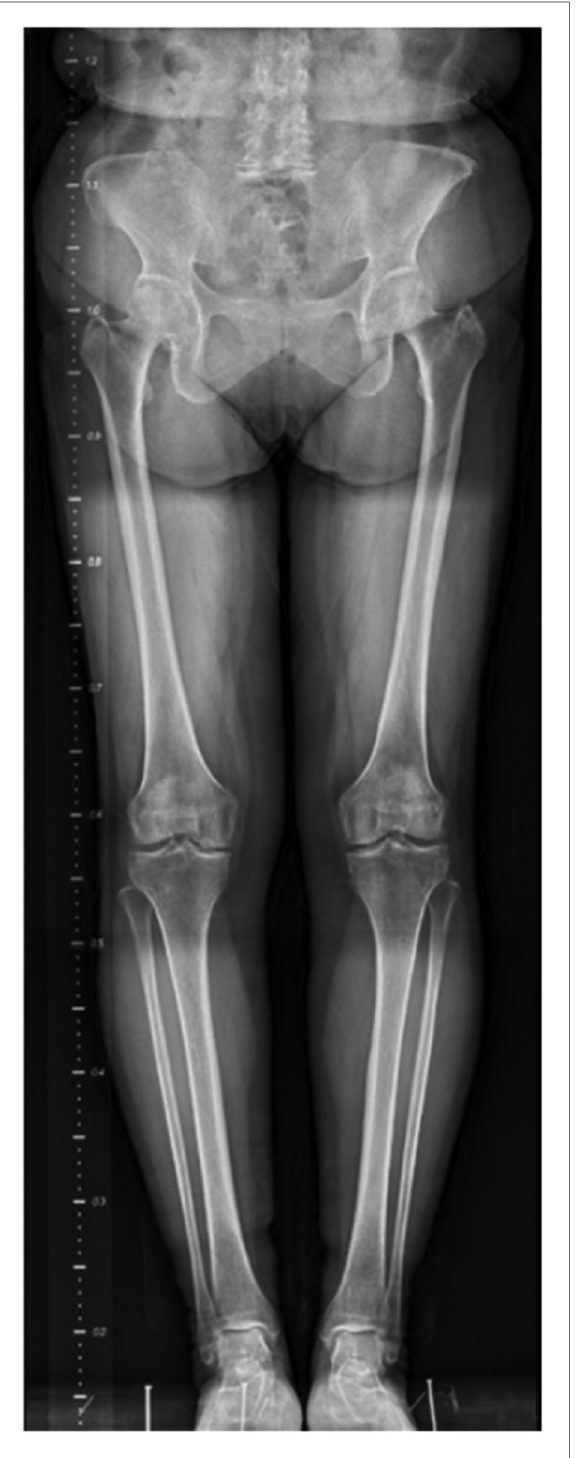
FIGURE 3 A full-length lower limb x-ray radiograph stitched using the proposed method based on canny algorithm.